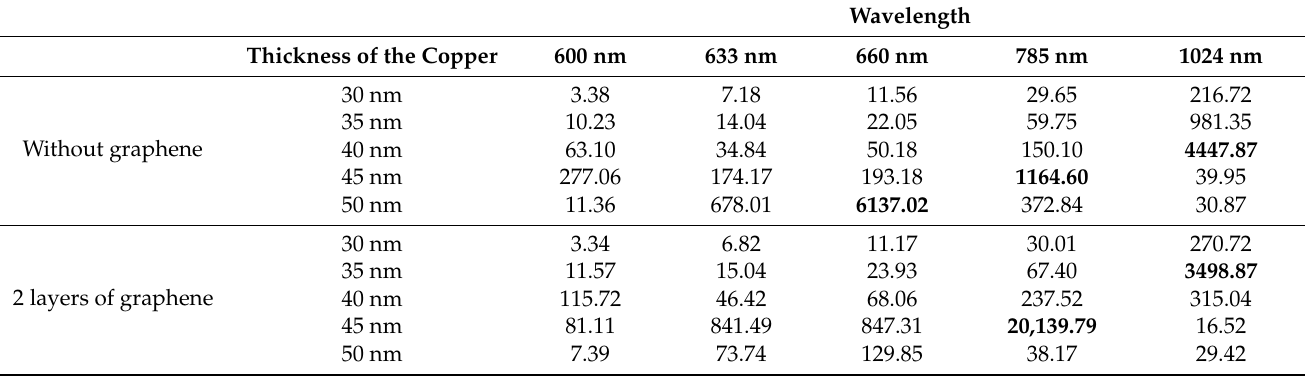
Table 1. Theoretical sensitivity ( µ m/RIU) calculation results for SPR biosensor with different thick- nesses of copper without graphene and covered with 2 layers of graphene. The best values are marked in